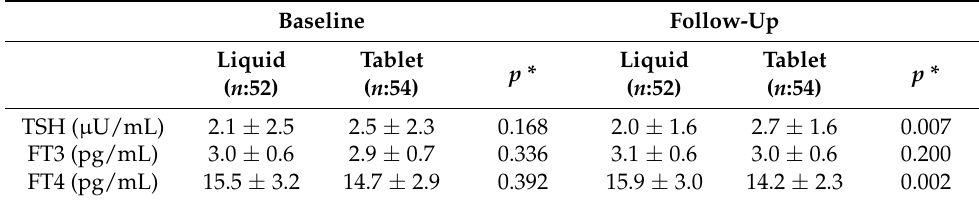
Table 1. Thyroid hormone profile of the study population.